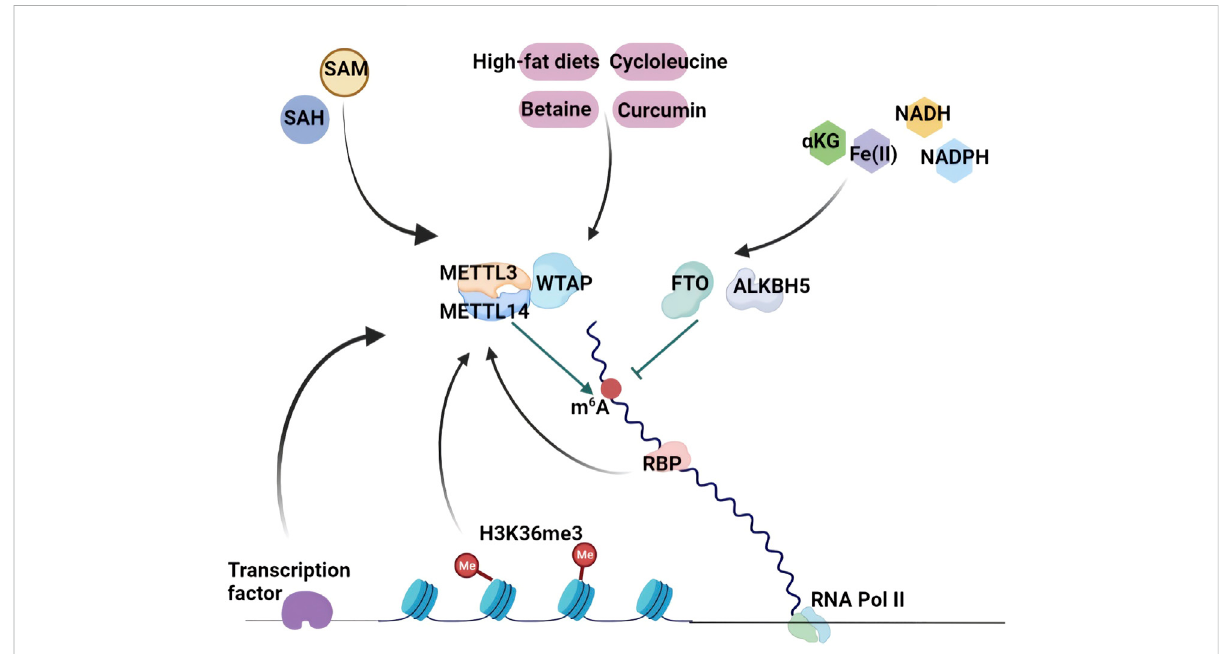
FIGURE 2 The biogenesis and regulatory mechanisms of RNA m 6 A Methylation. Methyltransferases and demethylases dynamically and reversibly direct the addition and removal of m 6 A RNA methylation. H3K36me3 guides m 6 A deposition in stop codons of CDSs and 3 ′ -UTRs. The dynamics of m 6 A regulation can be achieved by some transcription factors that recruit the m 6 A methyltransferase complex to speci fi c RNA loci in distinct cellular contexts. In addition, m 6 A methylation patterns are modulated by nutrition and metabolites including SAM, SAH, cycloleucine, betaine, curcumin, high-fat diets, α KG, NADH and